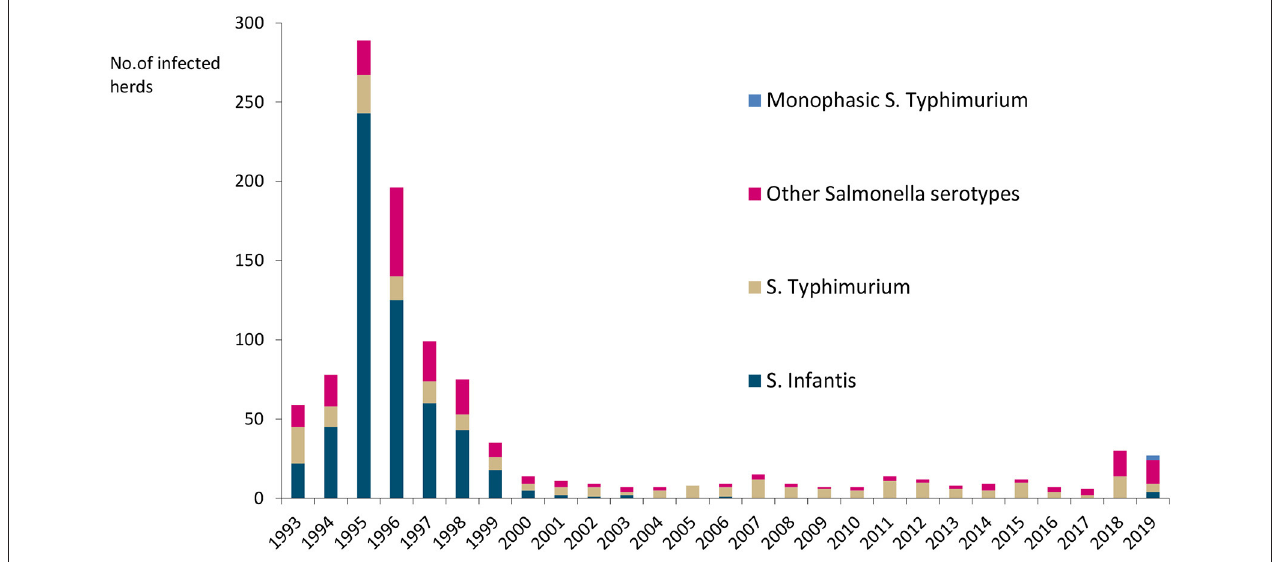
FIGURE 4 | Number of Salmonella -infected cattle herds and serotypes in Finland in 1993–2019. No Salmonella Dublin was detected.